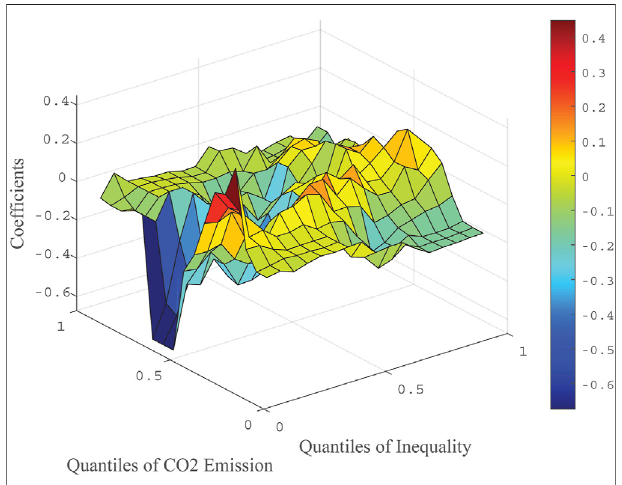
FIGURE 9 | The impact of carbon emission on income inequality